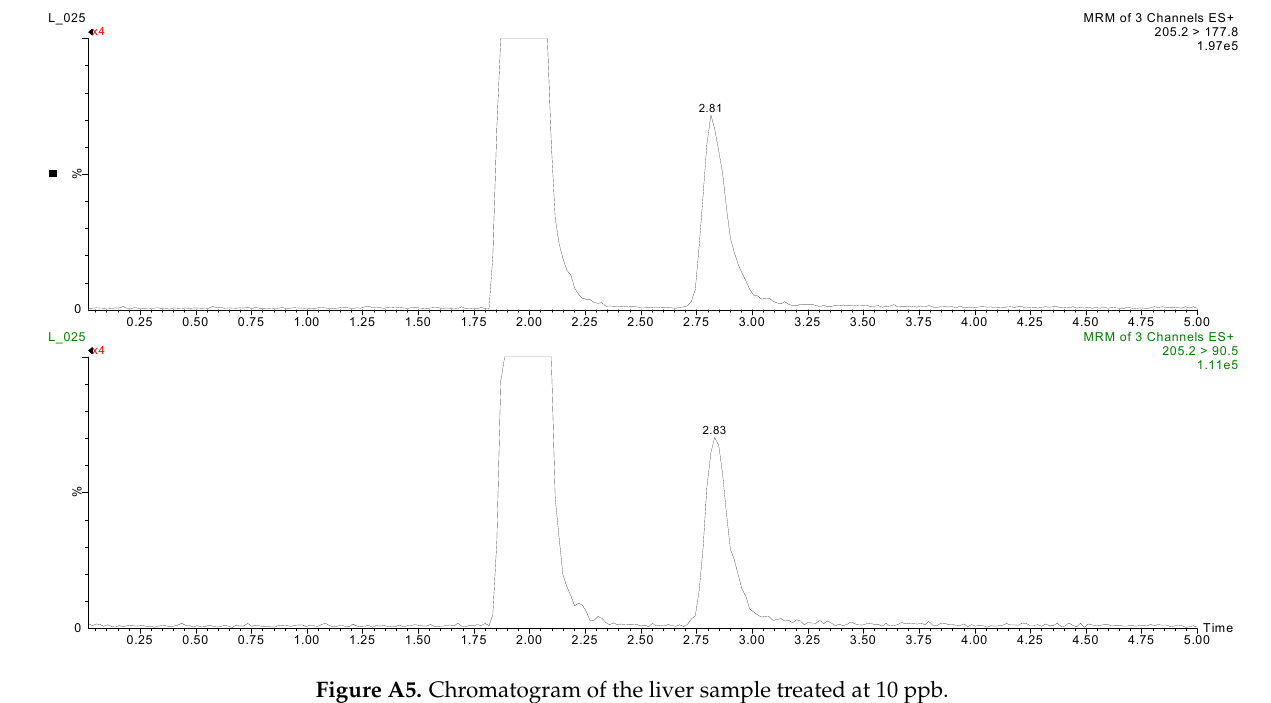
Figure A4. Chromatogram of the liver sample treated at the limit of quantification (LOQ) level.